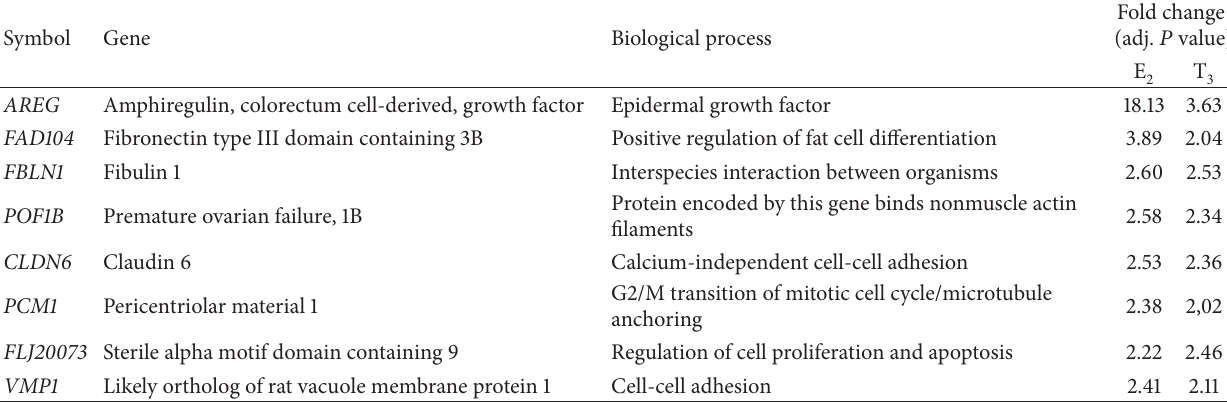
and T in MCF-7 cells. 2 3